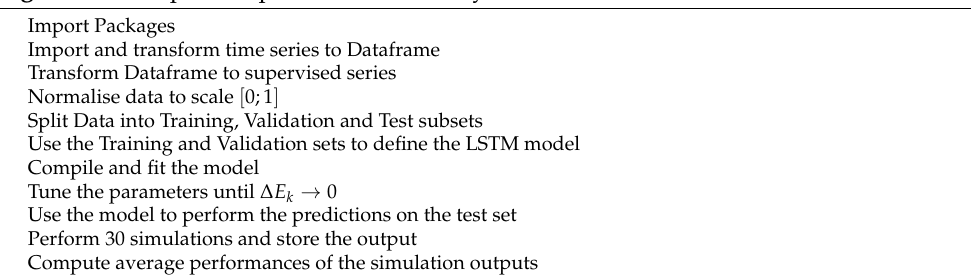
Algorithm 1 Steps to implement LSTM in Python